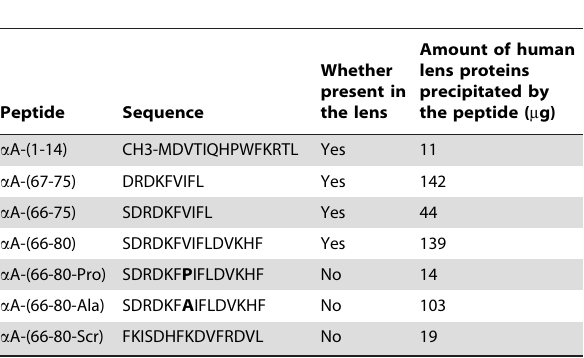
Table 1. Peptides tested in this study for their crystallin aggregation properties.